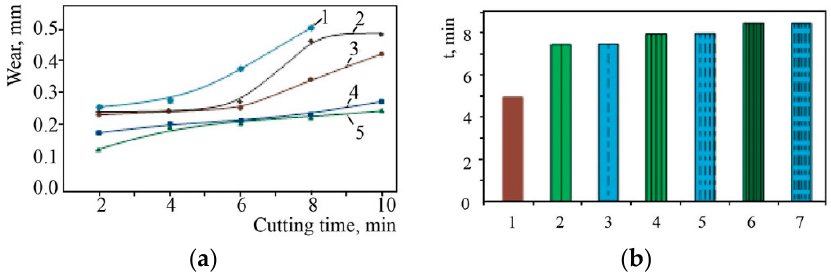
( d ) Figure 3. Wetting angles of water ( a ), LCL o ( b ), LCL r ( c ), and LCL s ( d ). The postoperative protective effect of LCL s , assessed by the appearance of the chips— the “indicator”—after 100 h (absence of traces of corrosion on the chip, Figure 4) following turning confirmed the reliability of its protective action [30,141,145]. Figure 4. View of steel chips following turning in LCL s ( a ) and water ( b ) after 100 h. The small angle of wettability of the LCLs with the steel surface ensured better pen-